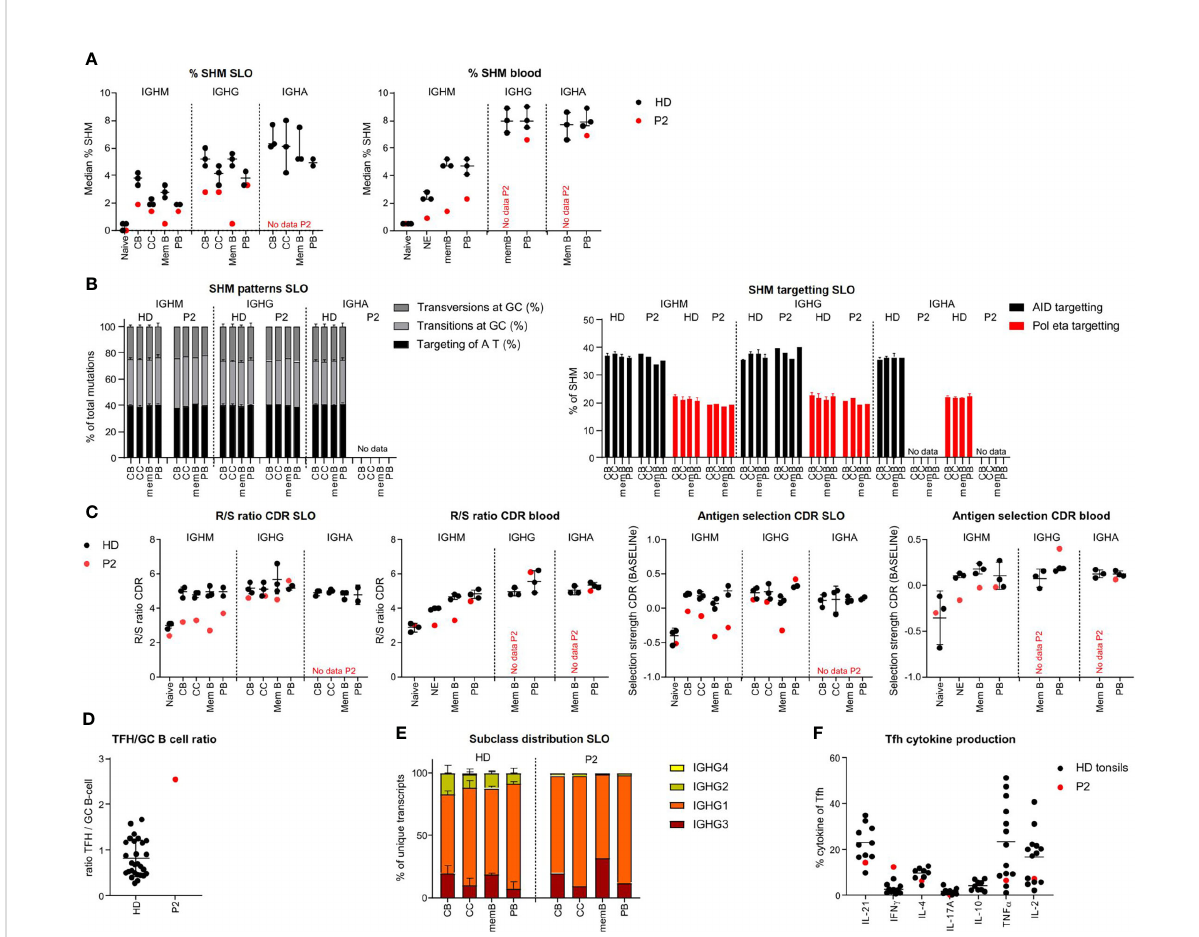
FIGURE 3 BCR repertoire analysis reveals reduced SHM, impaired antigen selection and altered subclass distribution in P2. (A) Median percentage of SHM in BCR transcripts of sorted B-cell populations. (B) SHM patterns and targeting in sorted B-cell populations. (C) Evaluation of antigen selection in sorted B-cell populations. (D) Tfh cell/B-cell ratio in the lymph node. (E) Subclass distribution in IGHG transcripts of sorted lymph node populations. (F) Cytokine production of Tfh